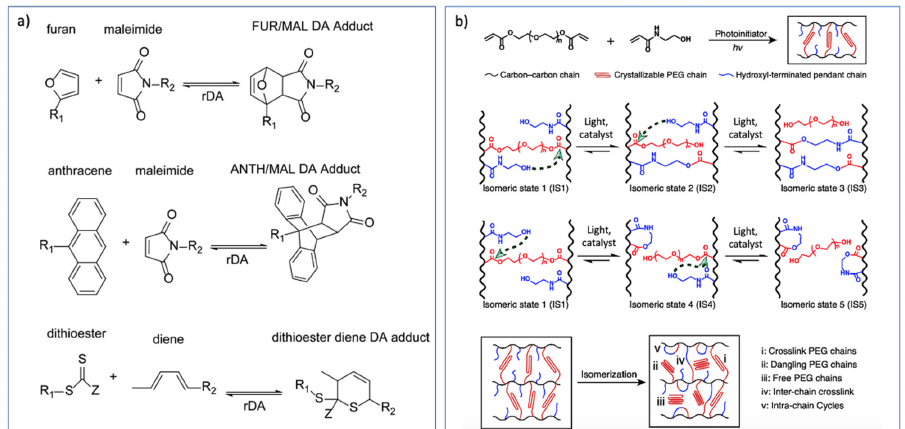
Figure 4. ( a ) Thermoreversible Diels–Alder adducts including Furan-maleimide, Anthracene-maleimide, and Dithioester diene (with permission from Wiley, Copyright 2016 [56]); ( b ) isomerization reaction via interchain and intrachain trans- esterification pathway (Reprinted with permission from ref. [74]. Copyright 2020 Nature).